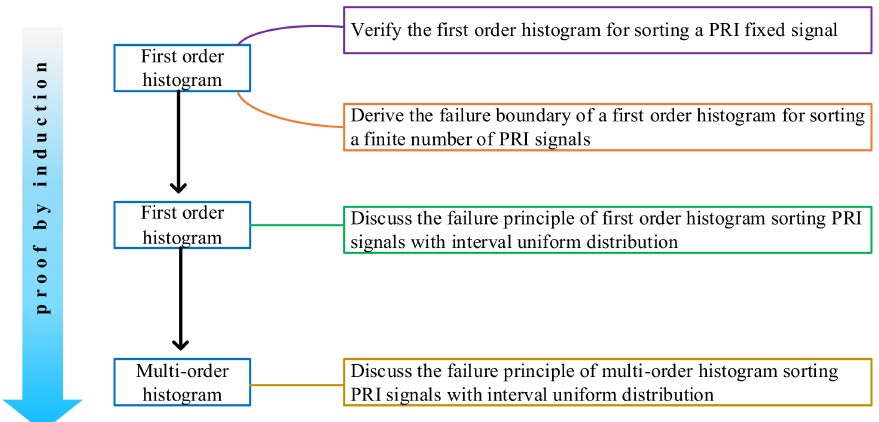
Figure 2. Logic diagram of the derived SDIF separation failure